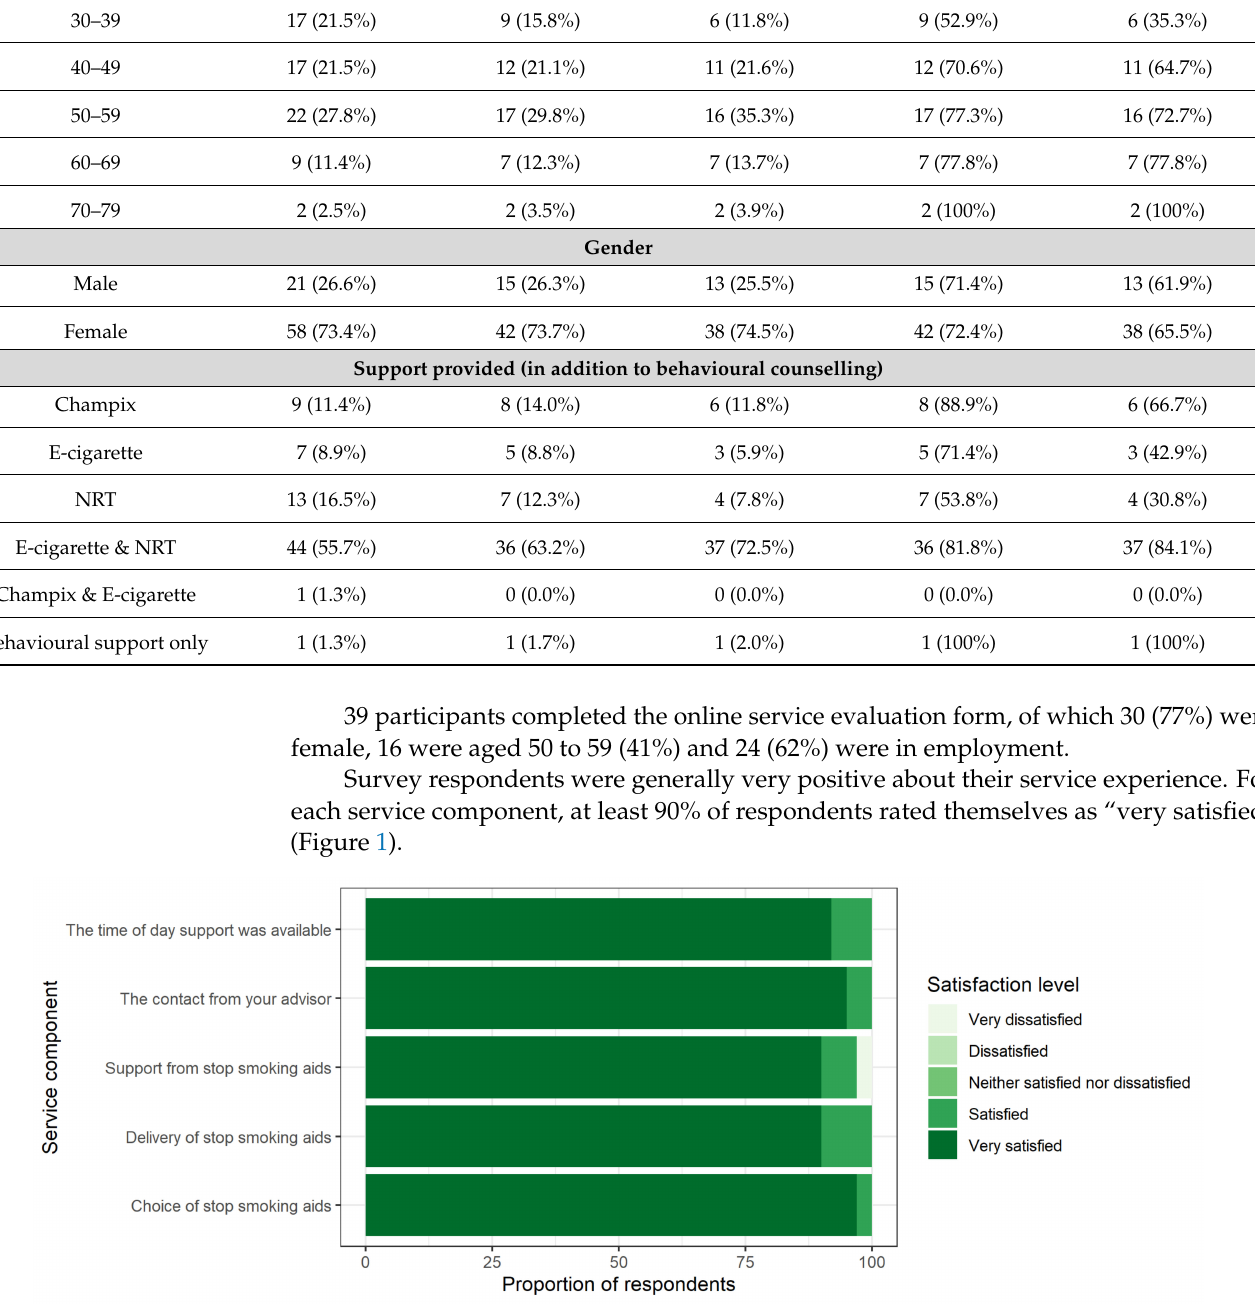
Figure 1. Service rating by